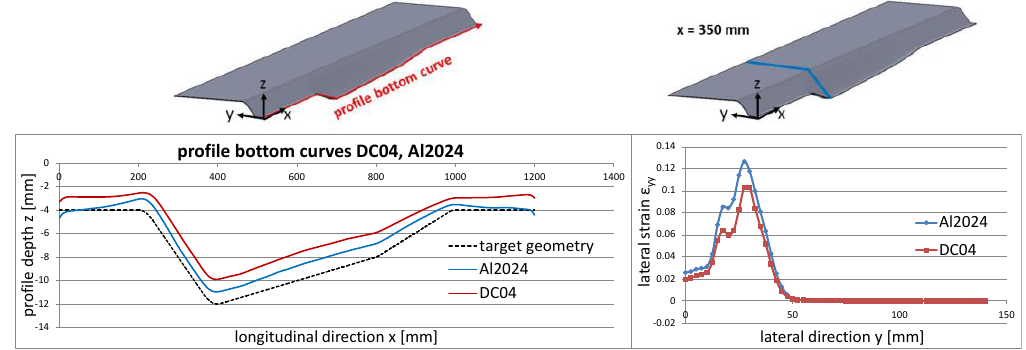
Figure 24. ( a ) Profile bottom curves and ( b ) lateral strain along the cross-section at x = 350 mm of a DC04 and Al2024 sheet blank.